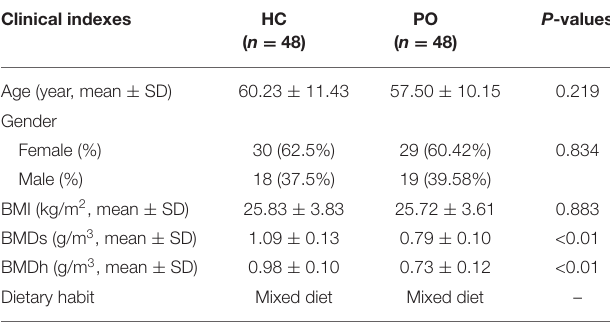
TABLE 1 | Clinical characteristics of the participants. Clinical